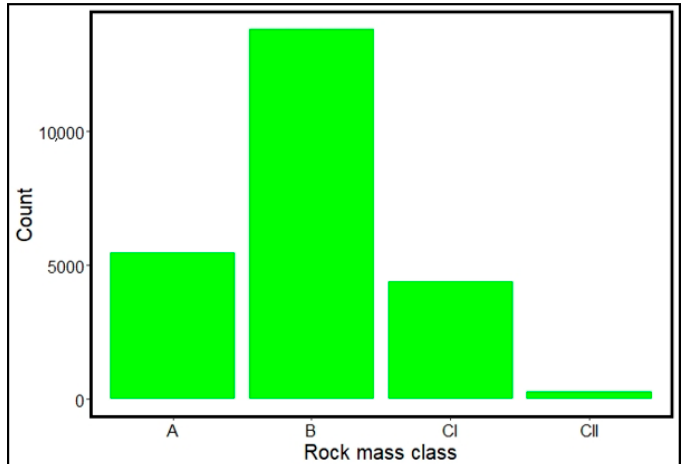
Figure 8. Amount of data from each rock class showing an imbalanced